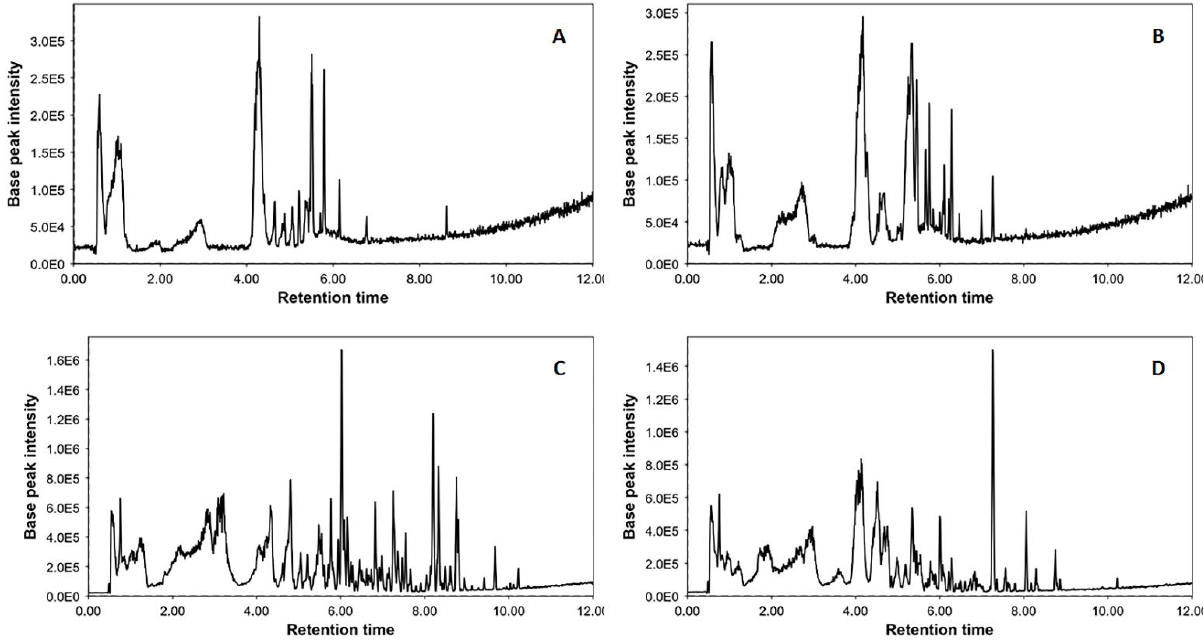
Figure 1. LC-ESI(-)-HRMS profiles of Greek wine samples: ( A ) Assyrtiko, ( B ) Malagouzia, ( C ) Agiortgitiko, and ( D ) Xinomavro.